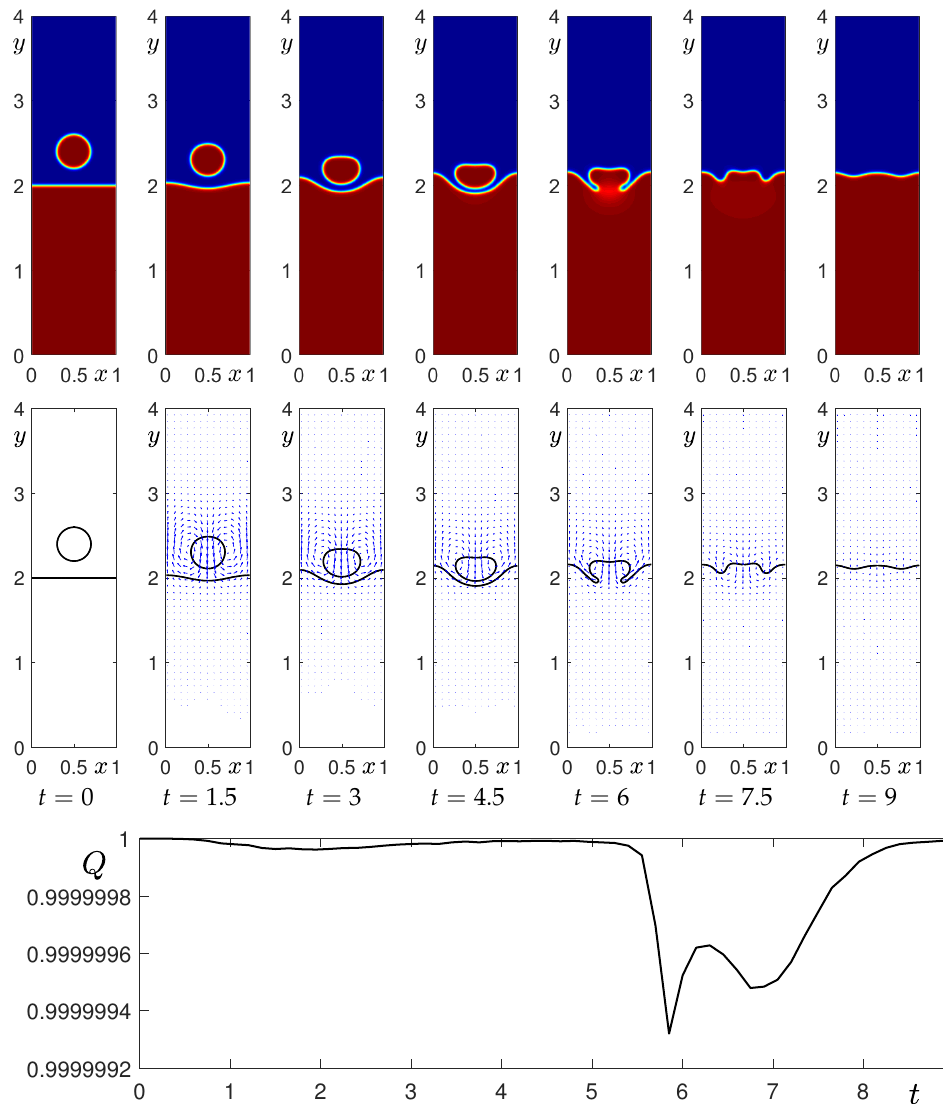
Figure 8. The top and middle rows display the snapshots of φ and velocity field. The computational moments are shown under each figure. The bottom row plots the evolution of Q n